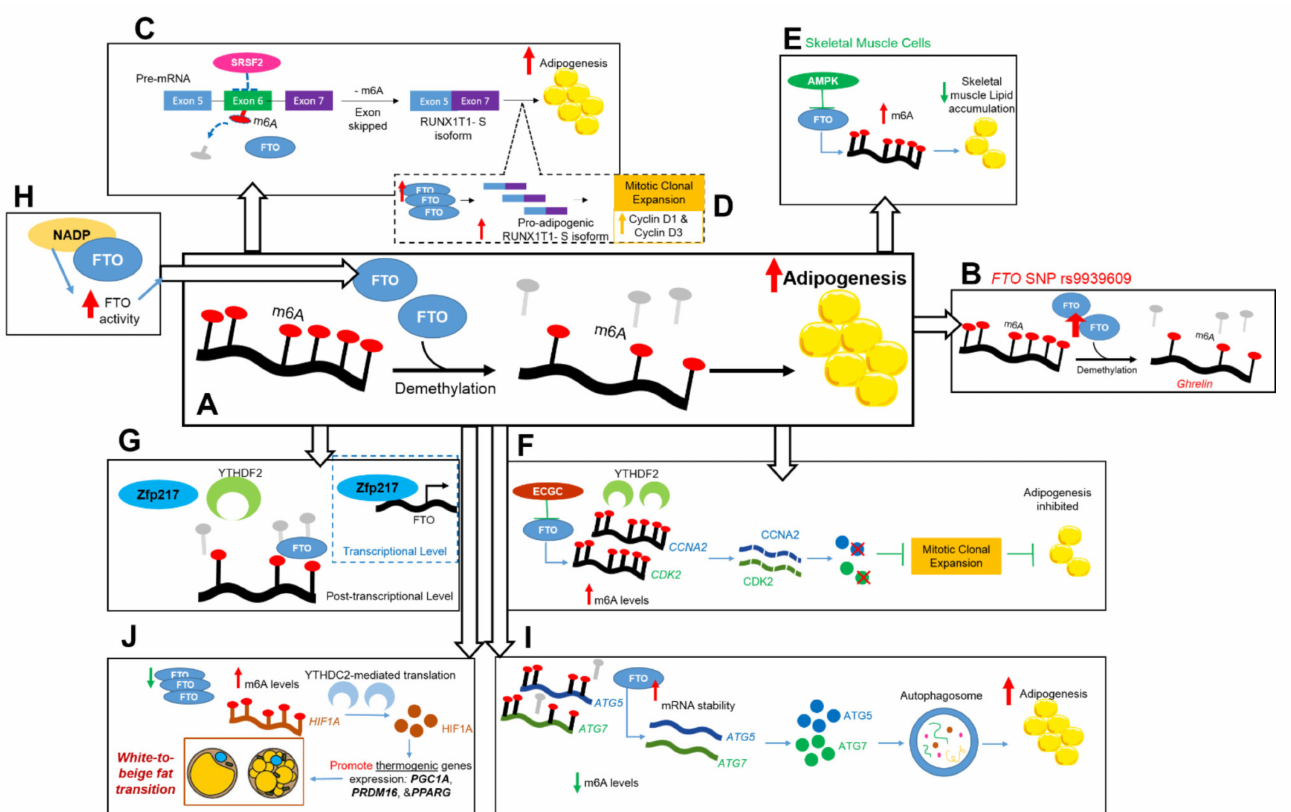
Figure 1. FTO molecular mechanisms in association with adipogenic pathways. ( A ) Inverse cor- relation between FTO overexpression and lipid accumulation as reported in porcine